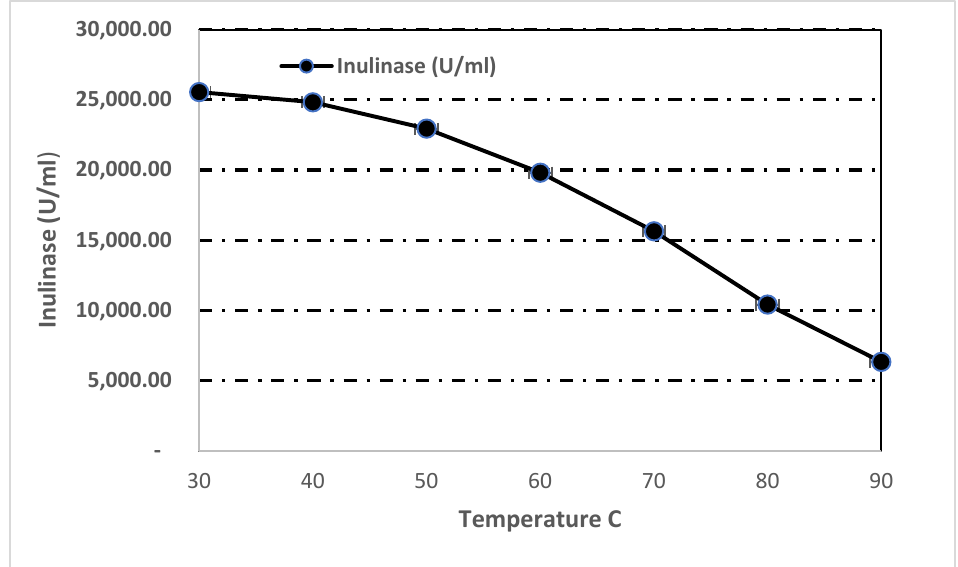
Figure 4. Thermostability of the purified inulinase from Rhizopus oryzae NRRL 3563.